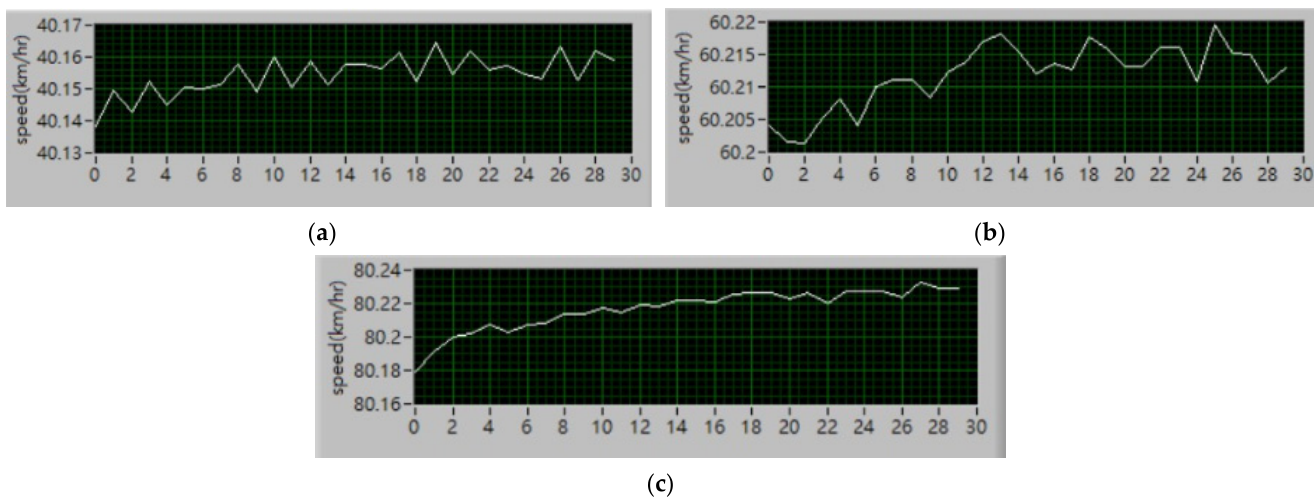
Figure 14. Estimated speed result: ( a ) speed of 40 km/h; ( b ) speed of 60 km/h; ( c ) speed of 80 km/h. Table 1. Mileage comparison table.